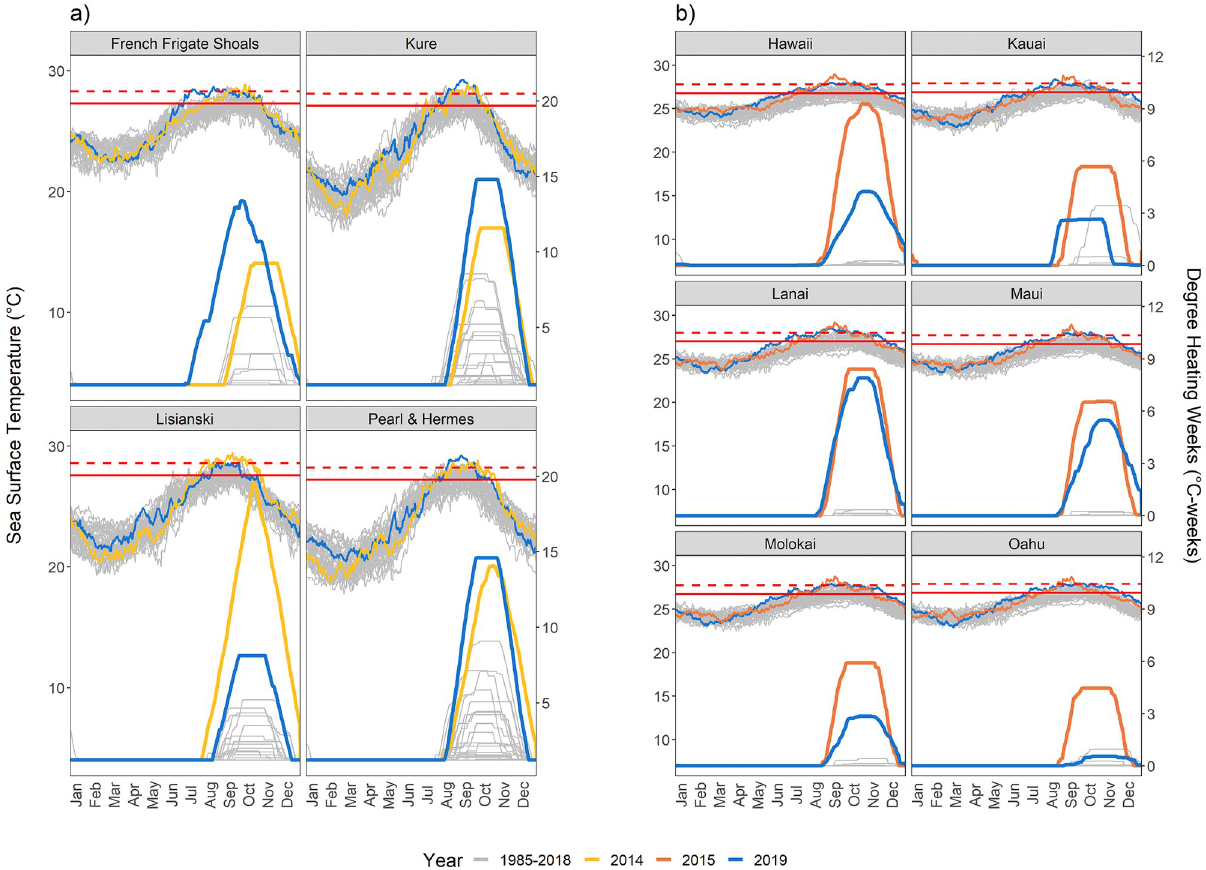
Fig 1. Sea surface temperature (SST) (top of panel) and NOAA Coral Reef Watch’s Degree Heating Weeks (DHW) data (bottom of panel) for the (a) Northwestern Hawaiian Islands (French Frigate Shoals, Kure Atoll, Lisianski Island, and Pearl and Hermes Atoll) and (b) Main Hawaiian Islands (Kaua‘i, O‘ahu, Moloka‘i, Maui, L ā na ʻ i, and Hawai‘i Island). Solid horizontal red line: the maximum of monthly mean SST climatology (MMM); dashed horizontal red line: bleaching threshold SST (1 º C above MMM). Yellow, orange and blue lines represent temperature and DHW trends from 2014, 2015, and 2019, respectively; gray lines represent all other years from